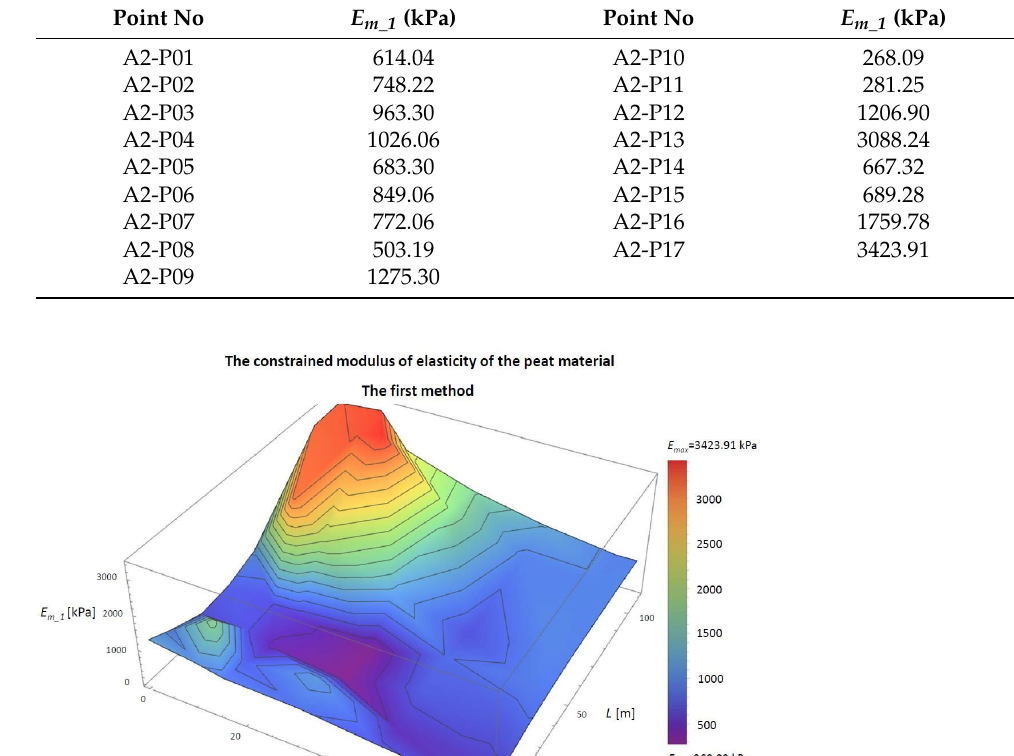
Table 6. The results of the constrained modulus of elasticity of the peat materials for full-scale experiment at the calculation points determined by the first method.